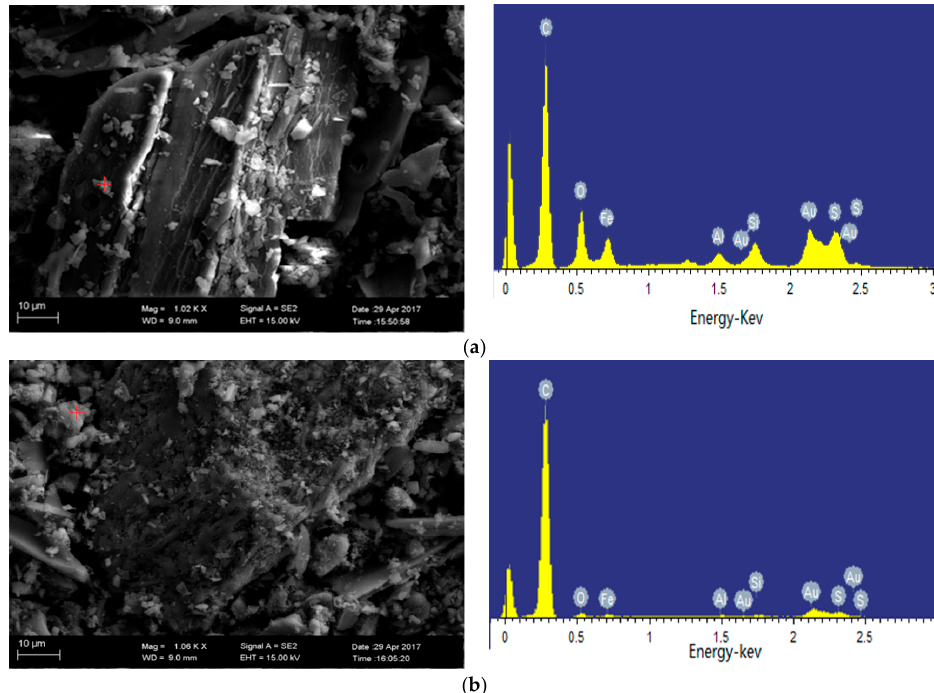
Figure 5. Iron-bearing minerals in Ulankarma lignite and its semi-coke (SEM-EDS secondary electron images). ( a ) Pyrite; ( b ) pyrrhotite.